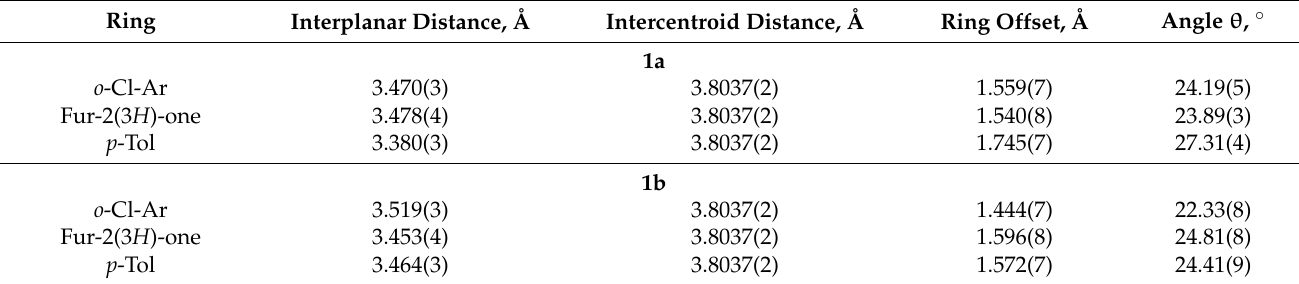
Figure 4. Extended packing diagram of the stacked molecules of ( 1 ), showing non-covalent interactions by dotted cylinders resulting in infinite chains parallel to the c axis. Hydrogen atoms omitted for clarity. One ( 1a ) molecules is marked blue, and one ( 1b ) molecule is marked green. Table 1. Parameters of the stacking interactions in the single crystal of ( 1a ); ( 1b